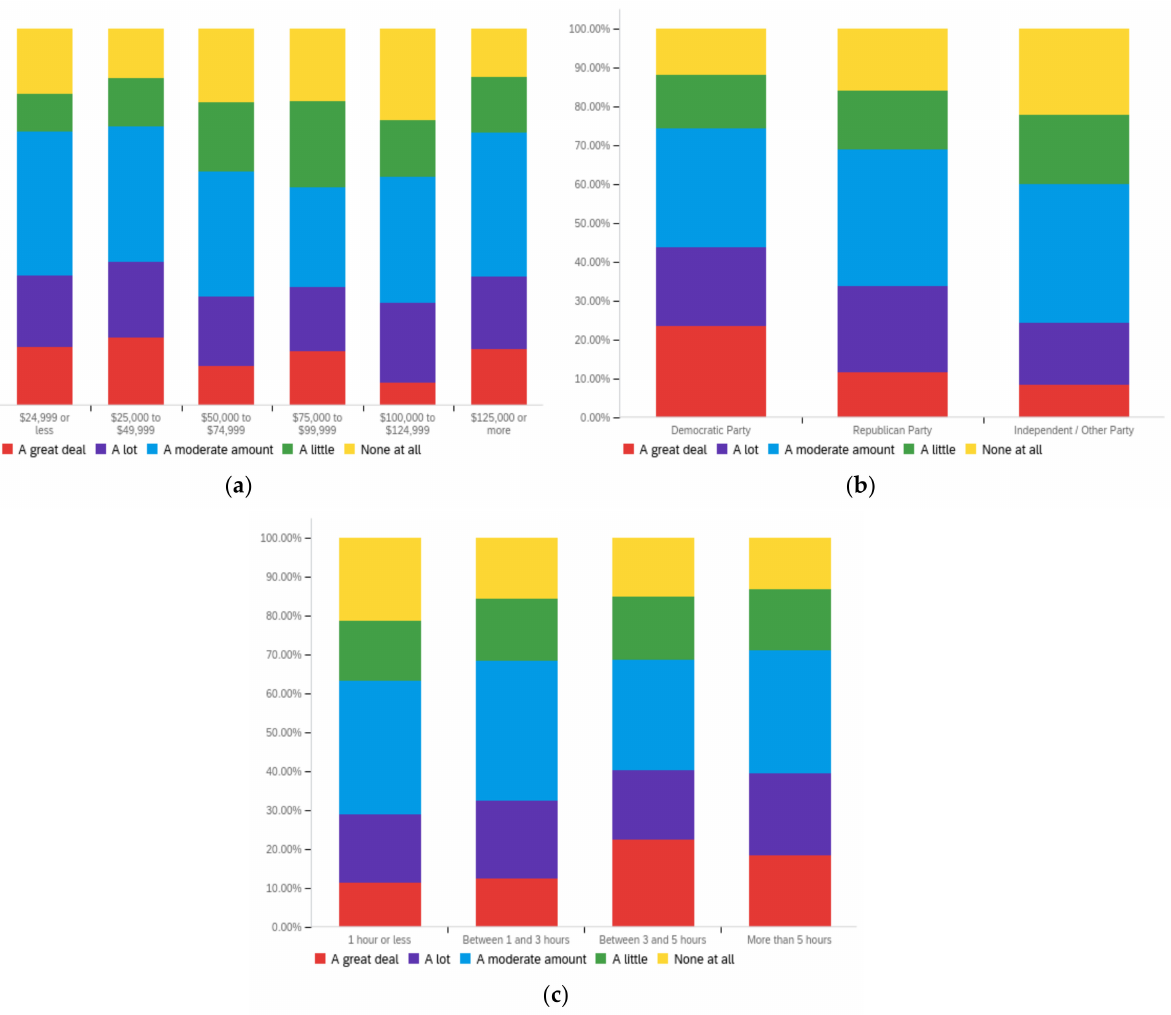
Figure A32. Article controversy level—others’ perception impact by: ( a ) income level (top left), ( b ) political affiliation (top right) and ( c ) online usage (bottom).